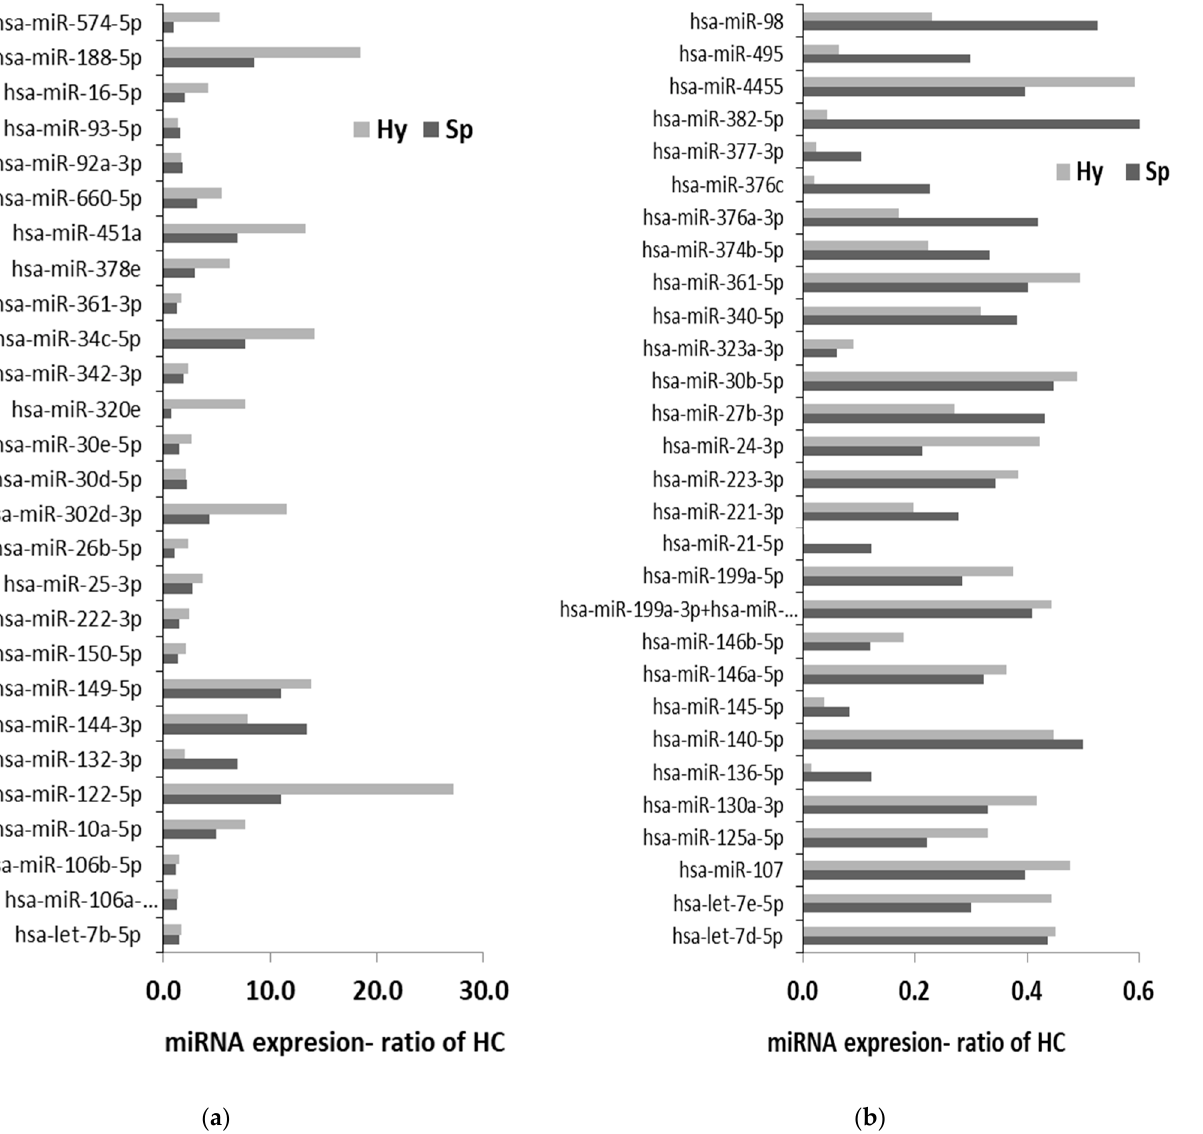
Figure 2. Extracellular vesicle (EV) miRNA expression screened using nano-string technology. EV pellets from two individuals each were pooled: from the hypersplenism (Hy) and splenectomized (Sp) subgroups, and from the control group. EV miRNA expression, represented as the ratio of the expression in the control group, for Hy (gray) and Sp (black). Different scales were used in ( a , b ) such as to emphasize the difference between two groups of miRNA. ( a ) shows miRNAs that were found to be higher in β T than control EVs, expressed as a ratio of the control group. In this graph, the scale represents the ratio > 1. ( b ) shows miRNAs that were found to be lower in β T than control EVs, expressed as a ratio of the control group. In this graph, the scale represents the ratio < 1.